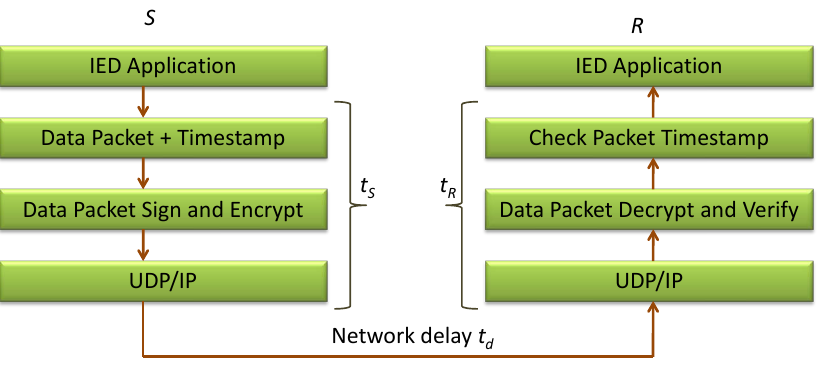
Figure 6. Time consumed in various